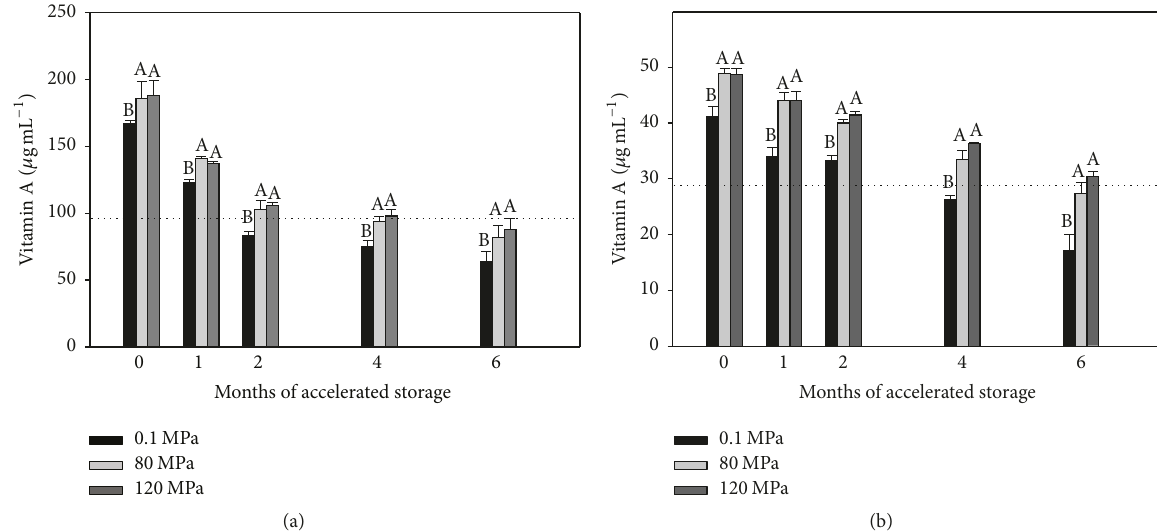
Figure 3: Effect of HPH treatments on the total vitamin A content of royal jelly (a) and iron food supplements (b) stored at 40 ∘ C ± 2 ∘ C and 75% ± 5% RH. Mean ( 𝑛 = 3 ± SD). Different letters within the same day indicate significant differences between pasteurization and HPH treatments at 𝑝 ≤ 0.05 . ns: not significant. The dotted line indicates 50% vitamin losses with respect to the initial contents shown in Table